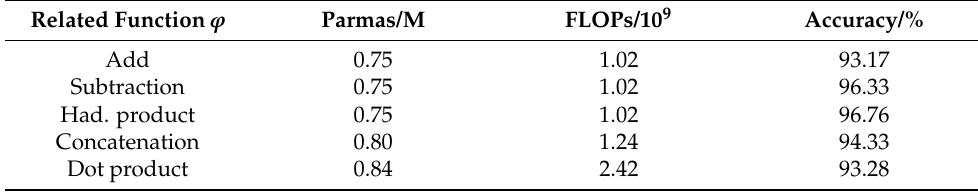
Table 5. Classification accuracy of different correlation functions.